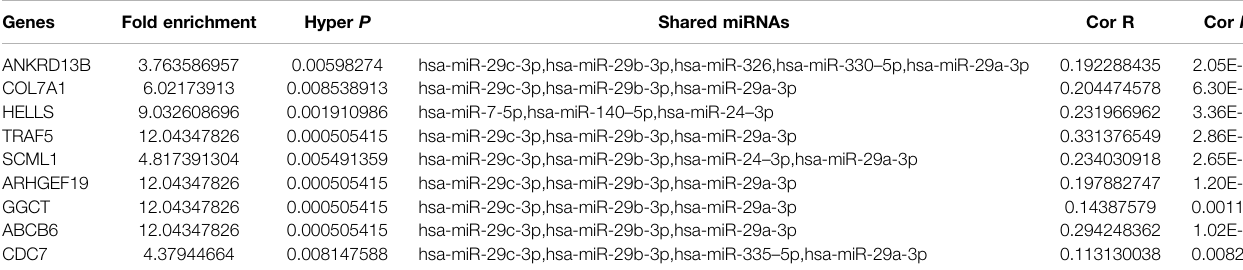
Figure 8 . Overall, the pro fi les of immune in fi ltration varied signi fi cantly between the tumor samples with high GSVA scores and those with low scores ( Figure 8A ). Also, lower CD4 + /CD8 + T-cell ratios were found in the tumor samples with high network GSVA scores than in the tumor samples with low scores. In the high-score group, along with the increase in the levels of CD8 + T cells in general was observed an increase in those of naïve CD8 + T cells. Notably, in contrast, lower levels of cytotoxic T cells were found for the high-score group than for the low-score group. Also, along with the relatively low levels of CD4 + T cells in the tumor samples with high scores, were relatively low levels of the T helper subsets Th2 and Th17. Other T cell subsets, namely Treg (nTreg and iTreg), Tex, Tem and MAIT cells were also downregulated. However, the B cells were upregulated. Regarding another lymphoid cell line, natural killer cell levels showed relatively low levels for the high-score group. Further, regarding the myeloid cell line, lower levels of monocytes, macrophages and neutrophils were also found for the high-score group.